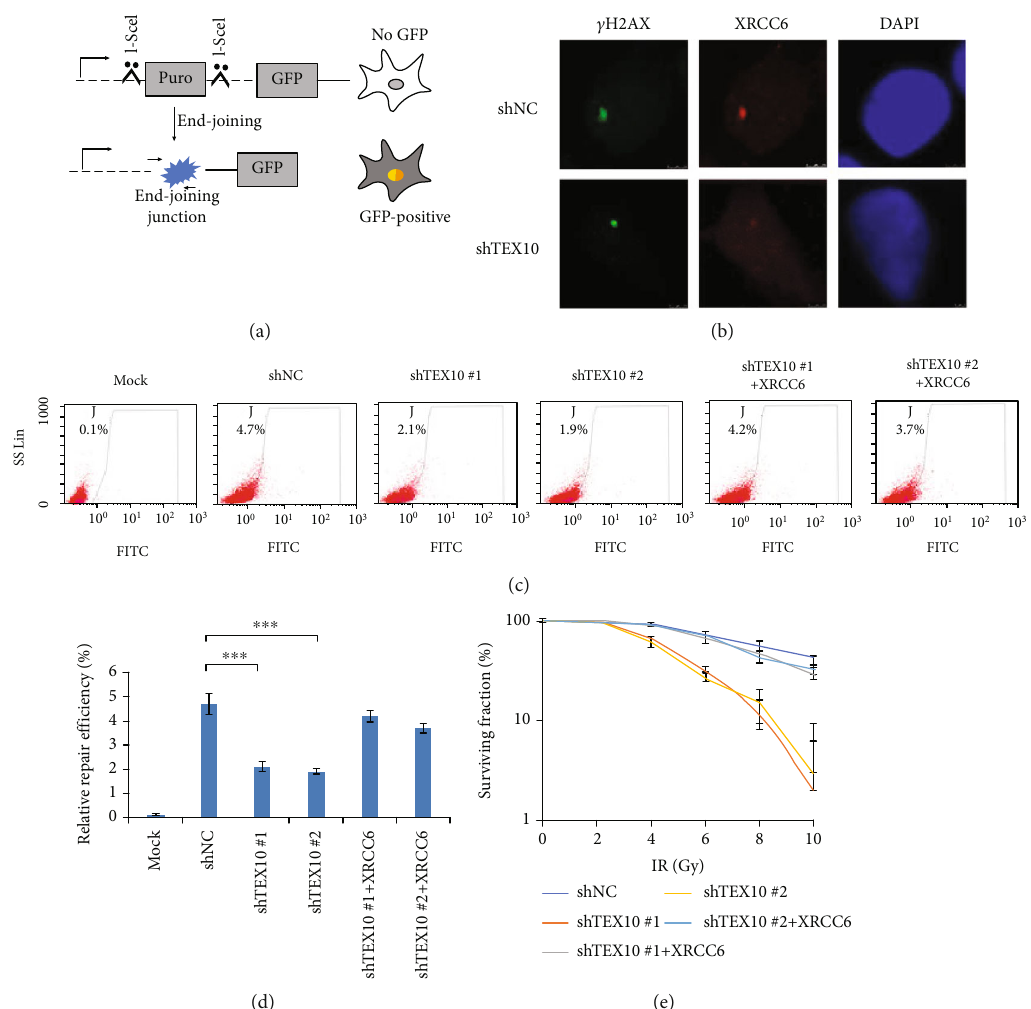
Figure 6: TEX10 promotes NHEJ e ffi ciency. (a) Diagram of NHEJ. Scissors indicate the cut sites of I-Sce I. The cut sites were cleaved after I- Sce I expression. GFP was expressed after NHEJ repair completion. (b) Fluorescent observation of DSB from T24 cells as suggested after I- Sce I expression. (c, d) E ffi ciency of the NHEJ repairs analyzed with fl ow cytometry. The percentage of GFP expression was regarded as repair completion for NHEJ repair tests. Shown is the mean ± SEM . ∗ P < 0 : 05 ; ∗∗ < 0.01; ∗∗∗ < 0.001, Student ’ s t -test. (e) T24 cells received the treatment by using increasing doses of IR and subjected to survival tests by CCK8 test. Shown is the mean ± SEM . ∗ P < 0 : 05 ; ∗∗ < 0.01; ∗∗∗ < 0.001, Student ’ s t